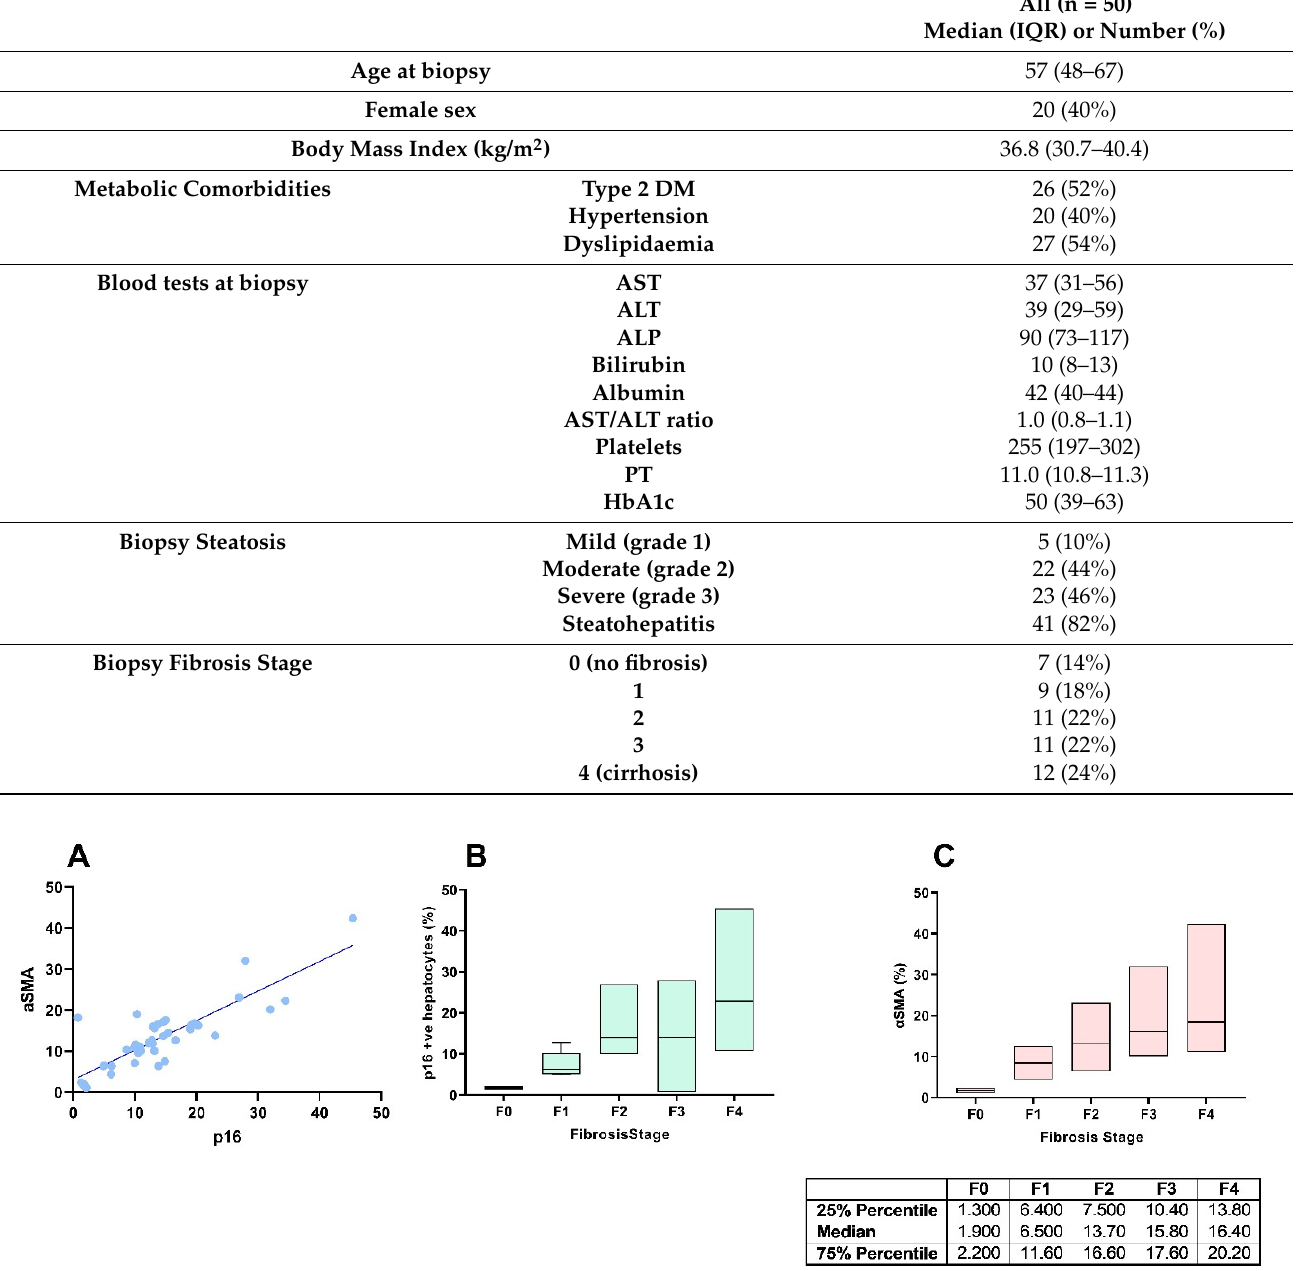
Figure 2. Association between p16 and α SMA expression and fibrous tissue using serial 10 µm sections cut from the same biopsy. High hepatocyte p16 expression was closely associated with increased hepatic stellate cell activation (shown by high α SMA expression) and thick fibrous tissue ( panel A ), and low p16 expression was closely associated with low α SMA expression and thin fi- brous tissue ( panel B ). Magnification is at 10× with insets for p16 expression is shown at magnifi- cation 40×. Scale bar length is 100 µm at 10× magnification. Table 2. Demographic and clinical characteristics of patients with non-alcoholic fatty liver disease (NAFLD). All (n = 50) Median (IQR) or Number (%) Age at biopsy